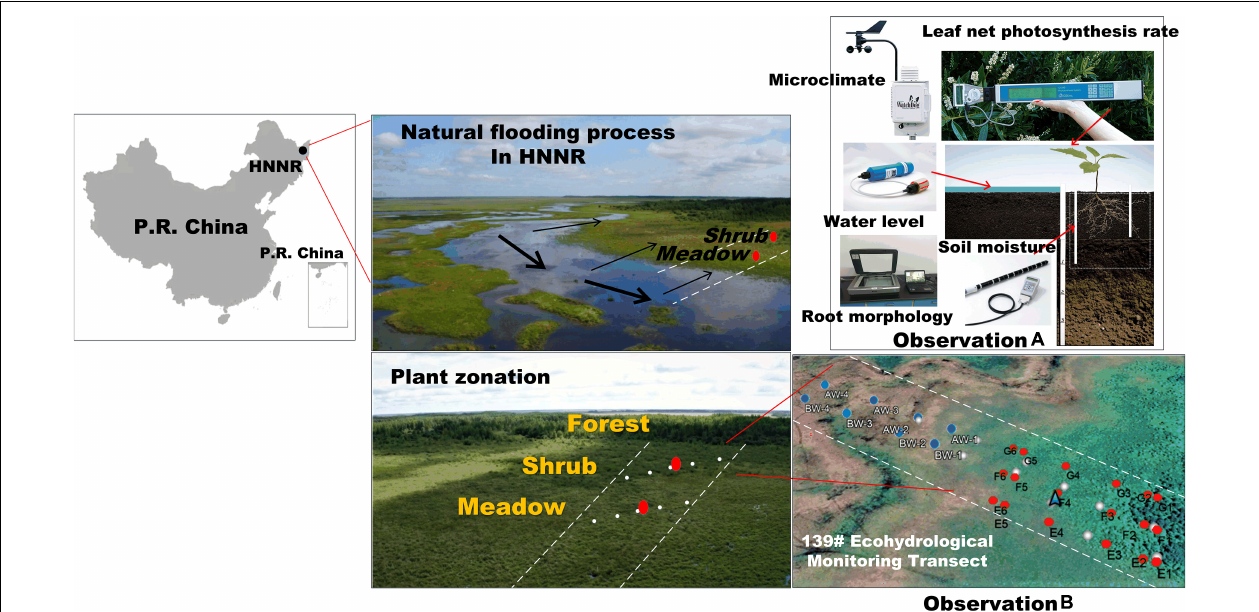
FIGURE 1 | Eco-hydrological experiments in an eco-hydrological monitoring transect (EMT-139) along a seasonal river in the HNNR in Heilongjiang Province, China. Observation B depicts the experimental transects established in the year 2011 (Li et al., 2011). In-situ eco-hydrological monitoring experiments were conducted continuously along this transect between the year 2011 and 2020. The observation matrix (red dots) covered the multi-layers’ root-zone soil water contents (RZ-SWCs) at the transitional zone, whereas the observation matrix (blue dots) represented the in-situ monitoring of the surface water level (SWL) of the seasonal Nongjiang River; The observation matrix (white dot) represented the check observations of the RZ-SWCs. Observation A illustrates the detailed eco-hydrological monitoring of each PFT on a site by site basis, which included in-situ monitoring of the leaf net photosynthesis rate (LNPR), RZ-SWC, SWL, and soil temperature (ST), as well as root and soil sampling of the meadow species (MeS) and shrub species (ShS).